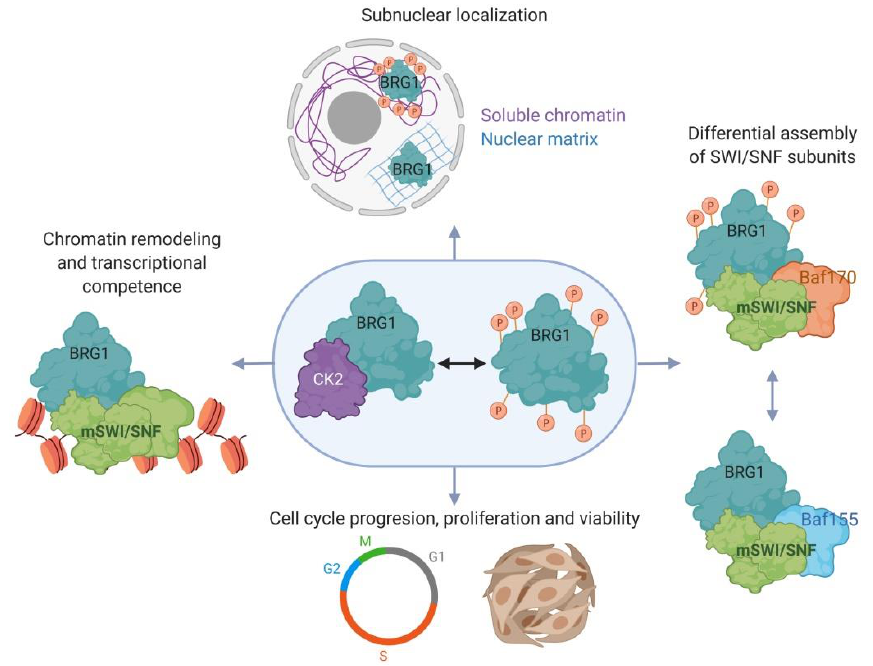
Figure 2. Casein kinase 2 (CK2) modulates mSWI/SNF activity in proliferating myoblasts. CK2-dependent phosphorylation of Brahma related gene 1 (BRG1) regulates the sub-nuclear localization and the subunit composition of the mSWI/SNF complex, viability and cell cycle progression, and the ability to remodel promoter chromatin and promote gene expression that allows myoblast proliferation. The diagram shows the presence or absence of phosphorylation of BRG1 for illustrative purposes. The exact number of phosphorylation sites in the presence of the different mSWI/SNF subunits has not been determined.